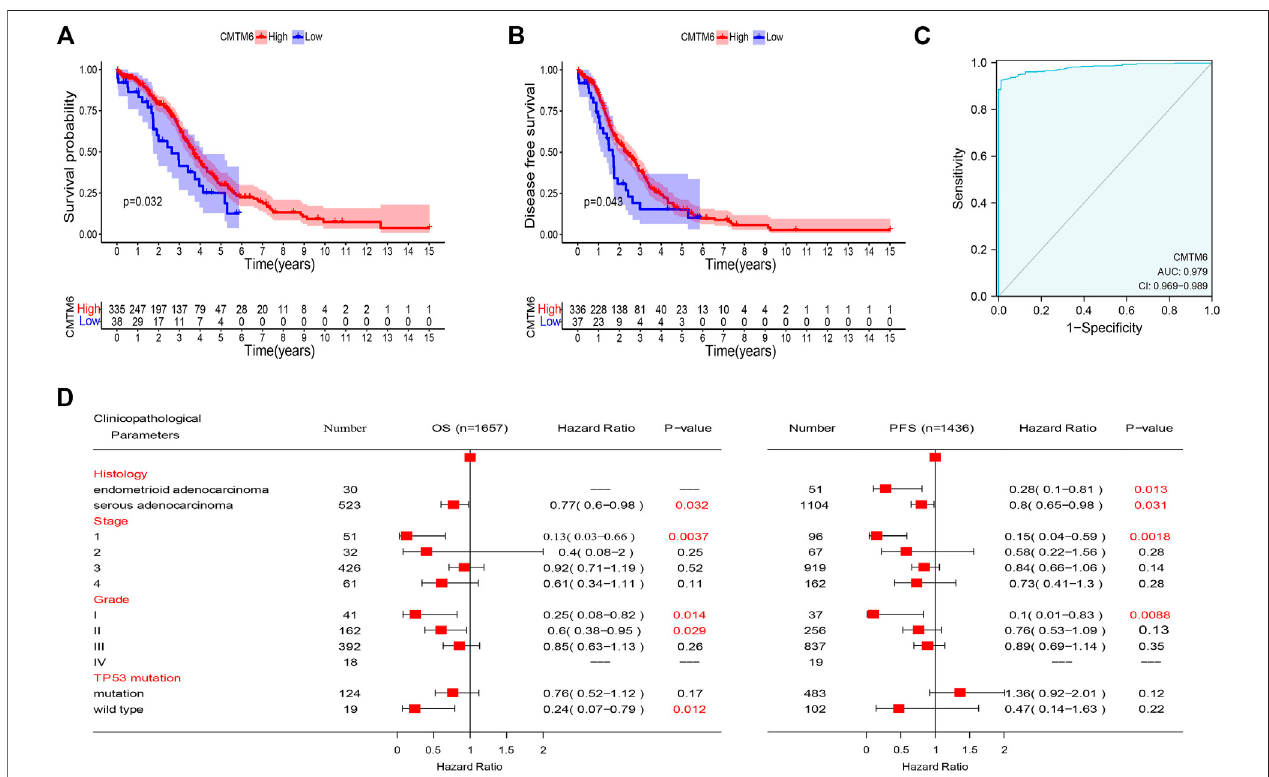
FIGURE 3 | Prognostic value of CMTM6 expression and ROC analysis. (A,B) Survival analysis of CMTM6 in OV showed that high CMTM6 expression has an increasedOSandDFSbasedonTCGAdatabase. (C) ROCcurveindicatedthebetterperformanceofsurvivalprediction. (D) Forestplotshowedthecorrelationbetween CMTM6 expression and clinicopathological parameters in OV patients.